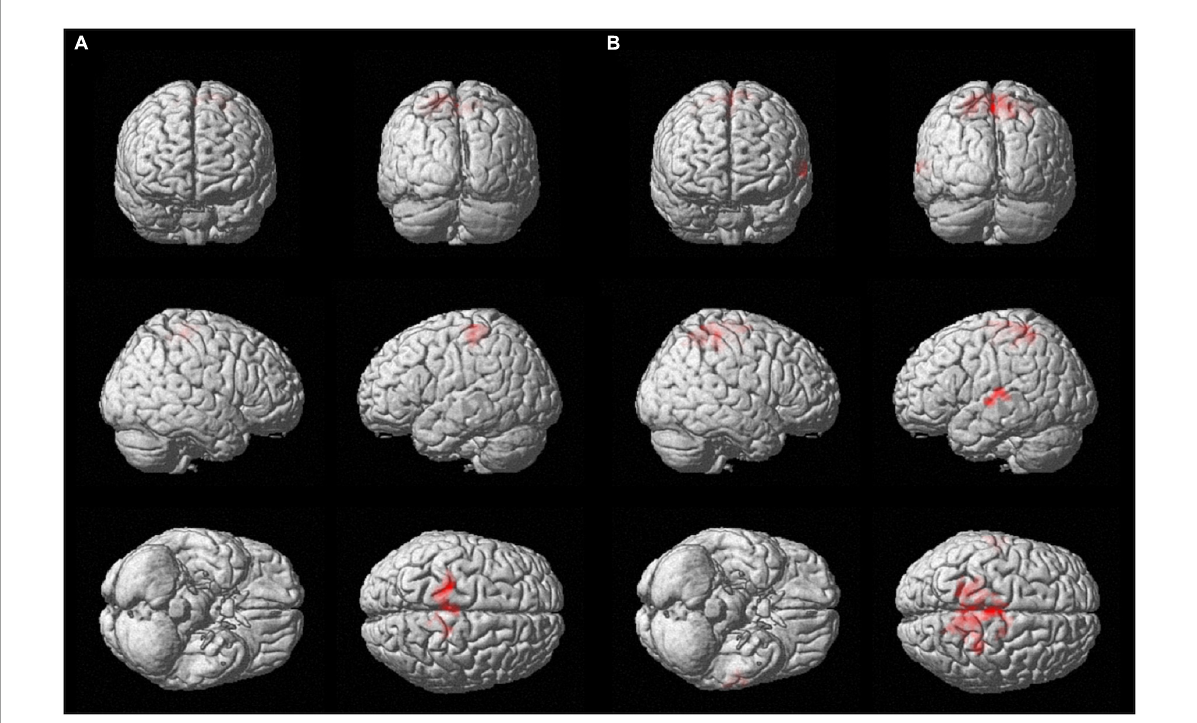
FIGURE3 Surface rendering showing voxels surviving the statistical contrasts between the group seed-to-whole-brain functional connectivity maps obtained with the different ROIs separately for the two brain hemispheres ( p < 0.05 FWE-corrected, extent of threshold k = 20 voxels, height threshold t = 7.05). (A) l-BA4 > l-hMHS and (B) r-BA4 > r-hMHS.